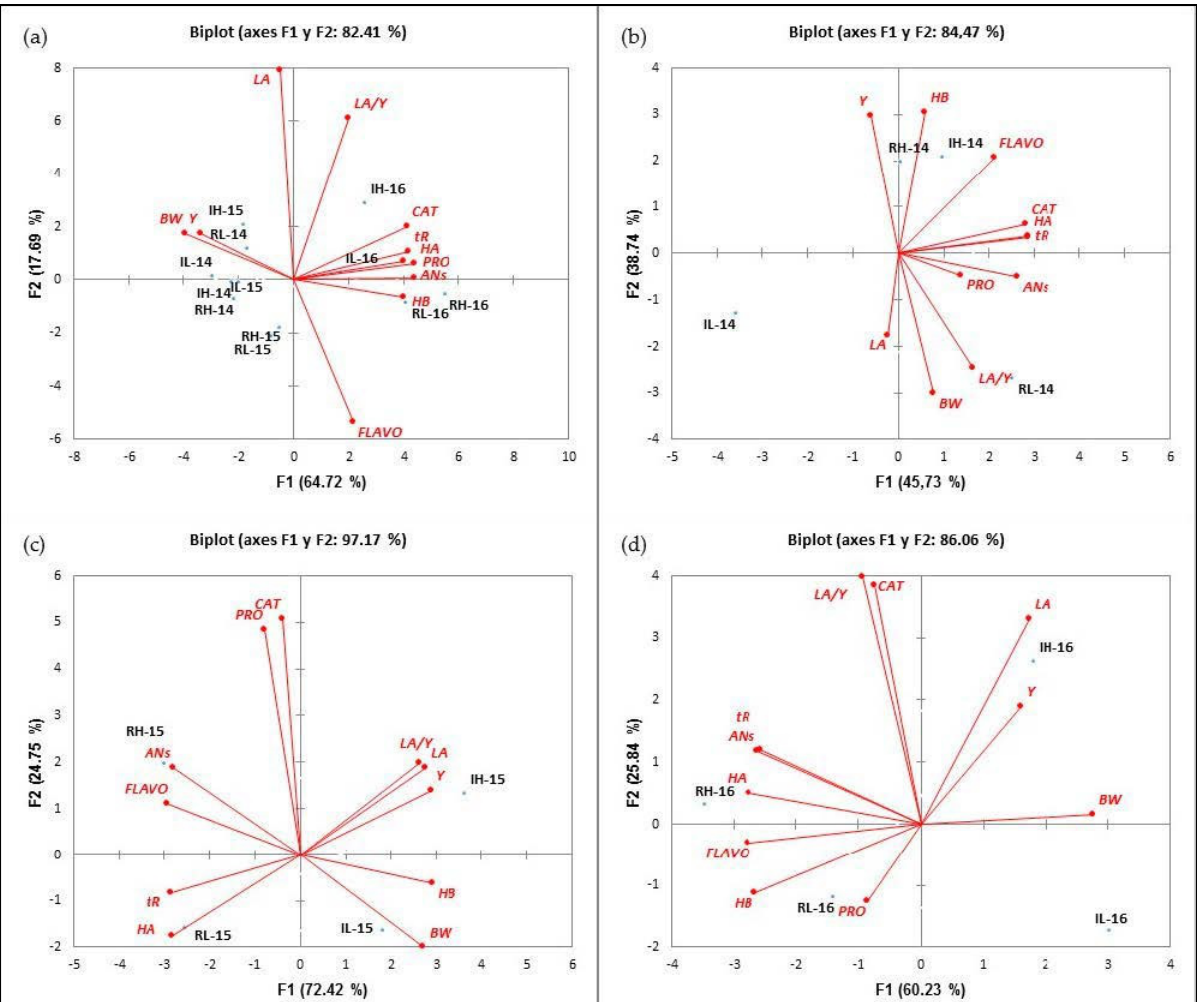
Figure 2. Classification of the treatments analyzed in the function of F1 and F2 for all the analyzed variables during the 2014-2016 ( a ), 2014 ( b ), 2015 ( c ) and 2016 ( d ) seasons.